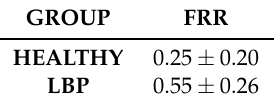
Table 3. Mean and standard deviation of the FRR, for Healthy and LBP subjects, obtained using the proposed